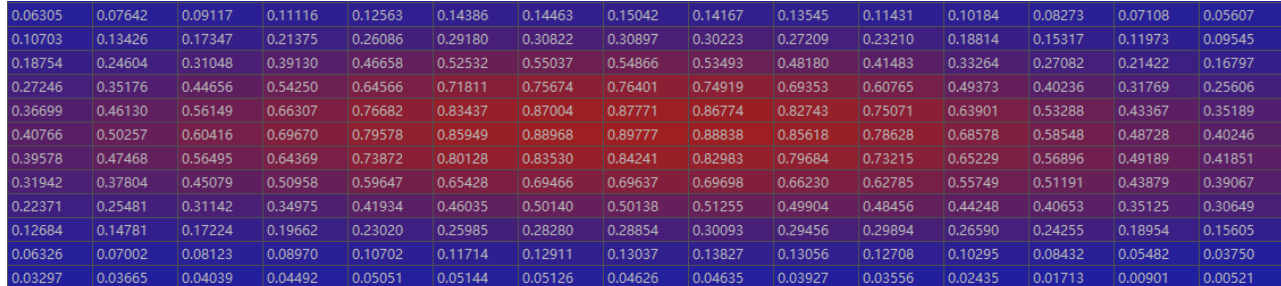
Figure 5. Hourglass three-dimensional convolutional neural network decoder with temporal incep- tion convolution layers.